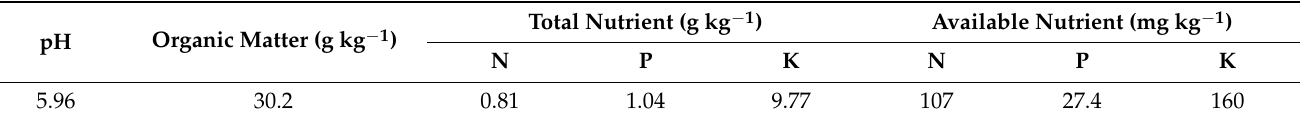
Table 1. Soil pH, organic matter, and total and available nutrients of the experimental field. Total Nutrient (g kg − 1 ) Available Nutrient (mg kg − 1 pH Organic Matter (g kg − 1 )